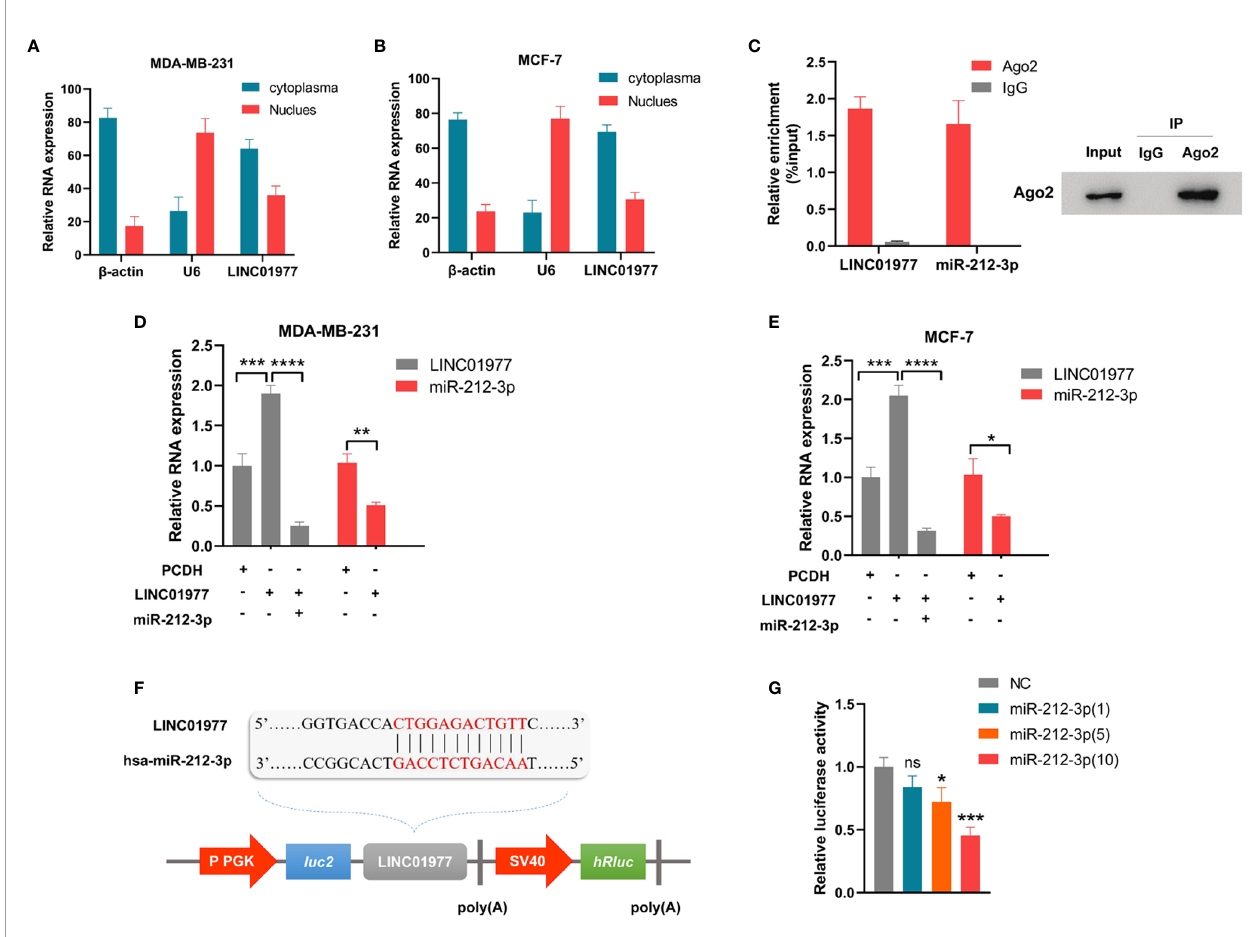
FIGURE 4 | LINC01977 served as a molecular sponge via binding to miR-212-3p. (A, B) The subcellular location of LINC01977. b -actin: positive control for cytoplasm; U6: positive control for nuclear. (C) Left panel: Real-time PCR analysis of LINC01977 and miR-212-3p enriched by Ago2 proteins in MCF-7 cells. Right panel: Western blot was used to con fi rm the speci fi c immunoprecipitation of Ago2. (D, E) Real-time PCR con fi rmed the interaction between LINC01977 and miR-212-3p in MDA-MB-231 and MCF-7 cells. (F) A schematic of wild-type LINC01977 luciferase reporter vectors. (G) Dual-luciferase reporter assay. NC: negative control of miR-212-3p mimics. (*p < 0.05, **p < 0.01, ***p < 0.001, and ****p < 0.0001; Student ’ s